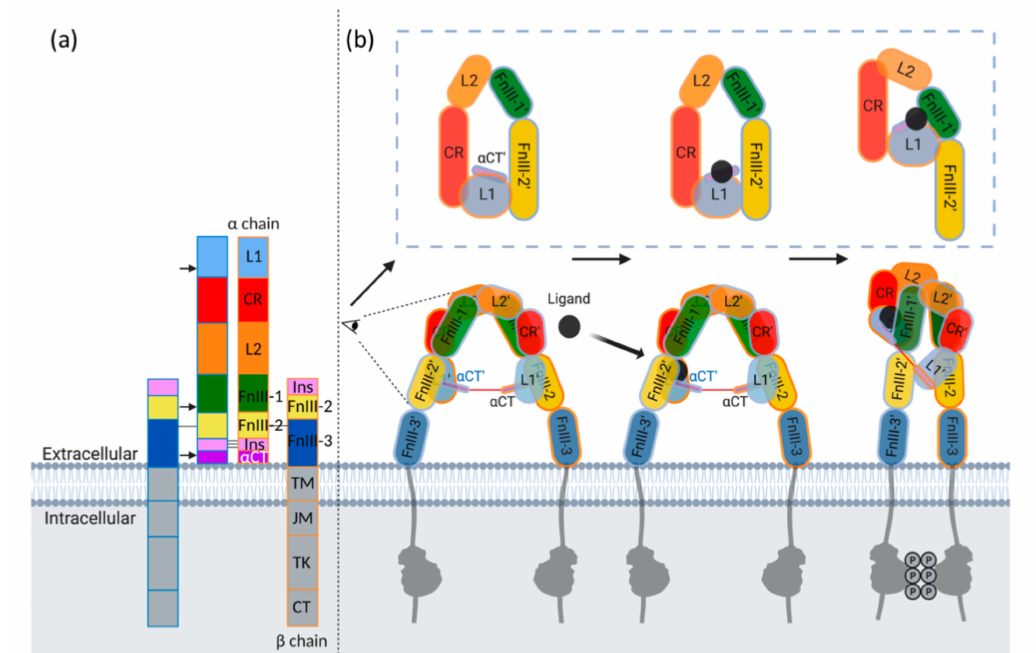
Figure 3. ( a ) Domain structure of IGF-1R and IR receptor tyrosine kinases. Individual αβ